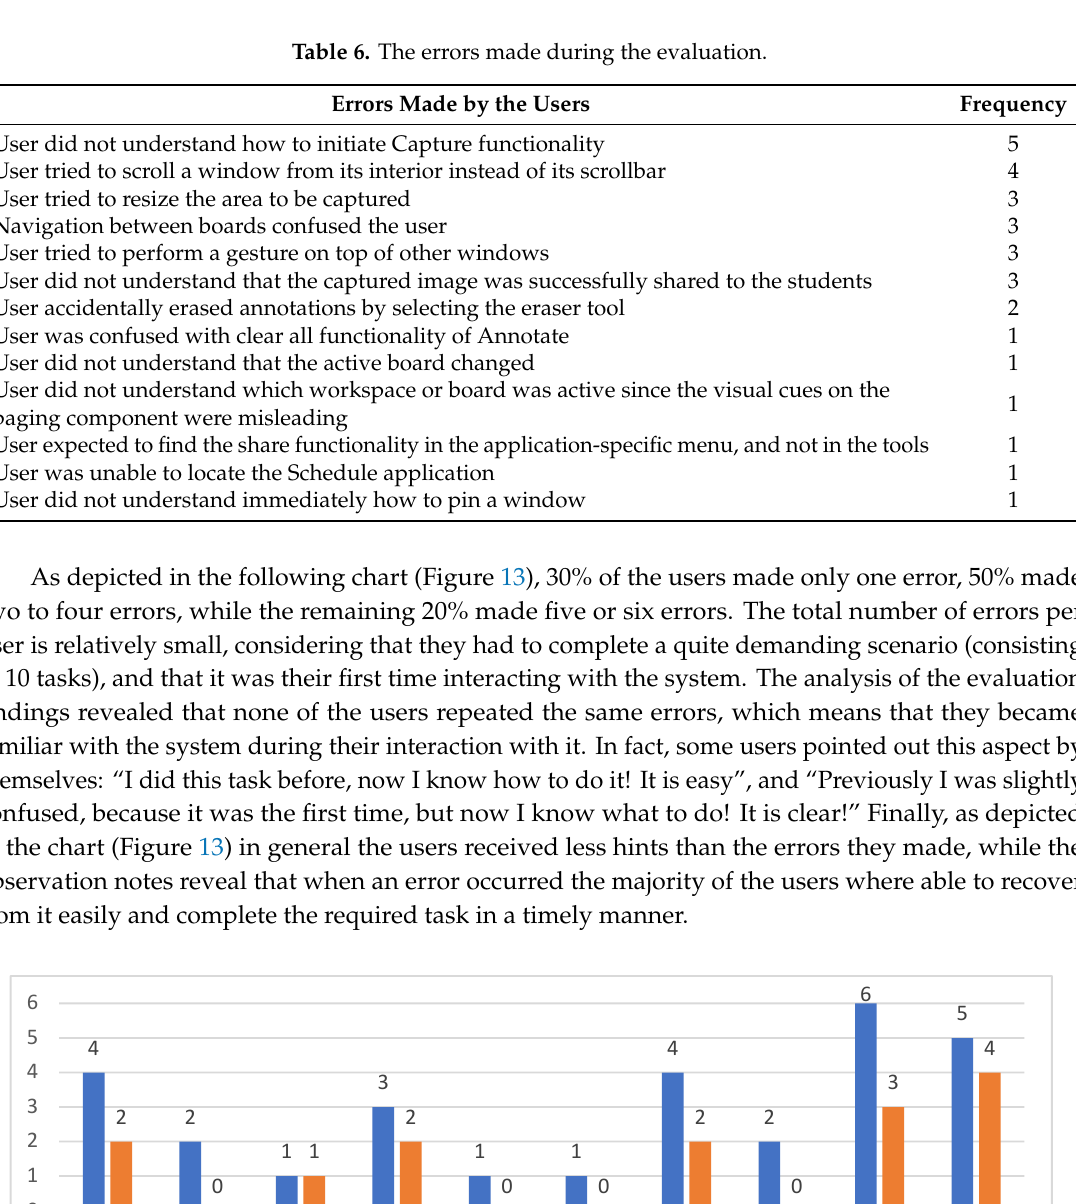
Table 6. The errors made during the evaluation.